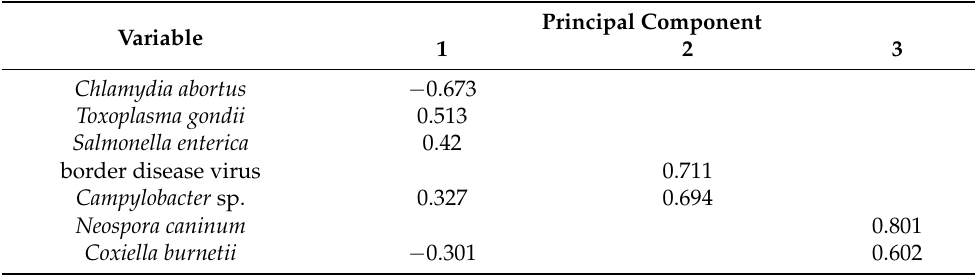
Table 6. Rotated component matrix of pathogens identified in caprine abortions: loadings of principal components 1, 2 and 3 on variables related to absence/presence of pathogens in caprine samples. Coefficients below 0.3 (absolute value) have been suppressed for easier interpretation.